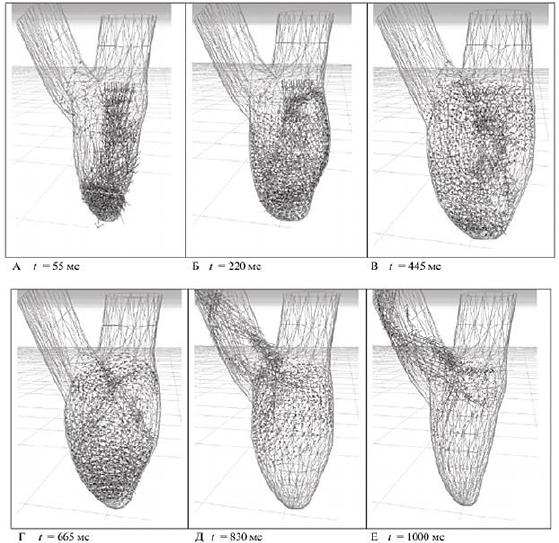
Fig. 15. Visualization of the flow of a model fluid with simulated exposure to C5 trabeculae. The particle velocity is